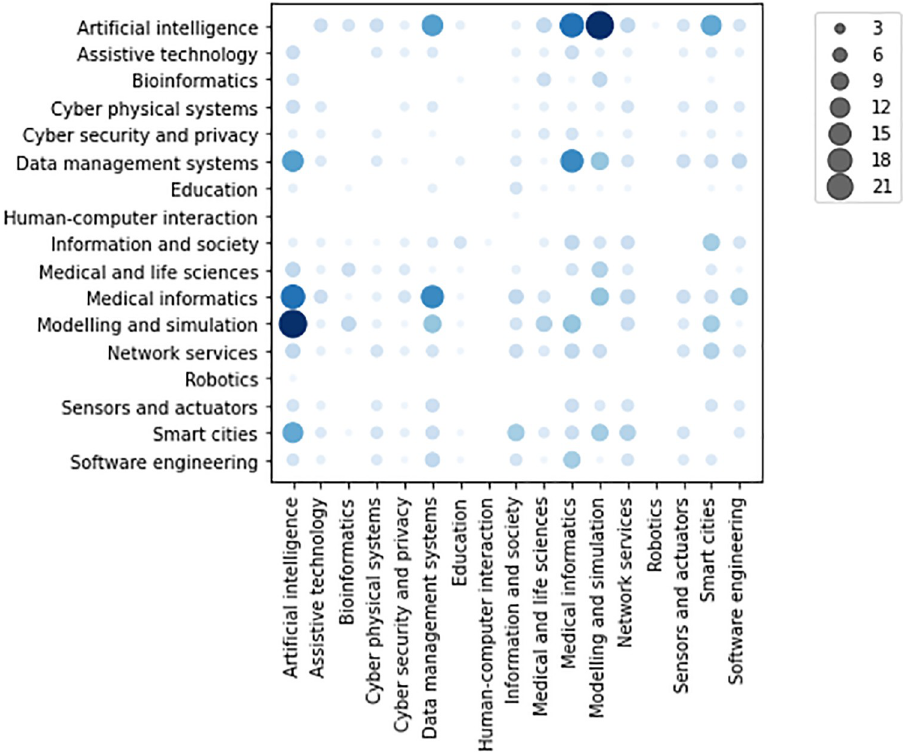
Fig 8. Co-occurrence of scientific domains indicated as high relevant for the surveyed